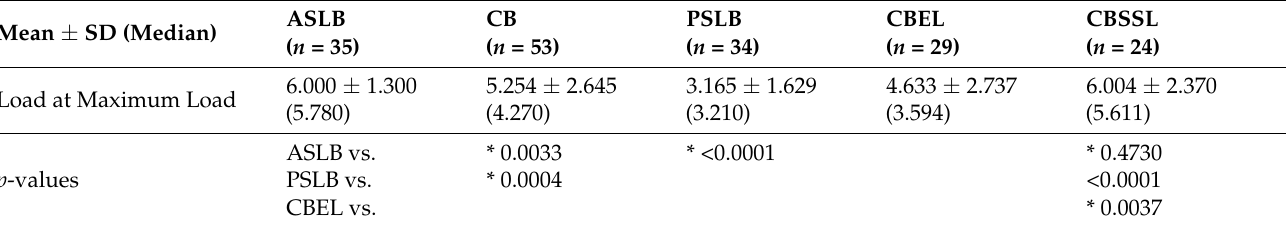
Table 6. Means and SD—load at maximum